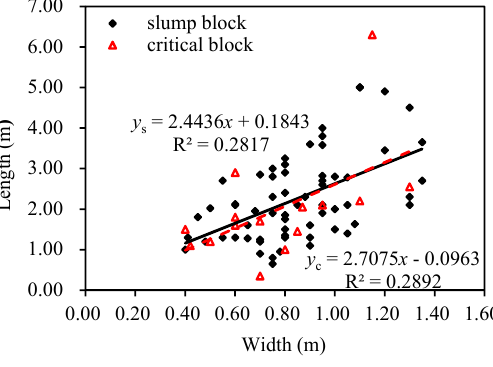
Figure 5. Relationship between width and corresponding length of slump and critical blocks.